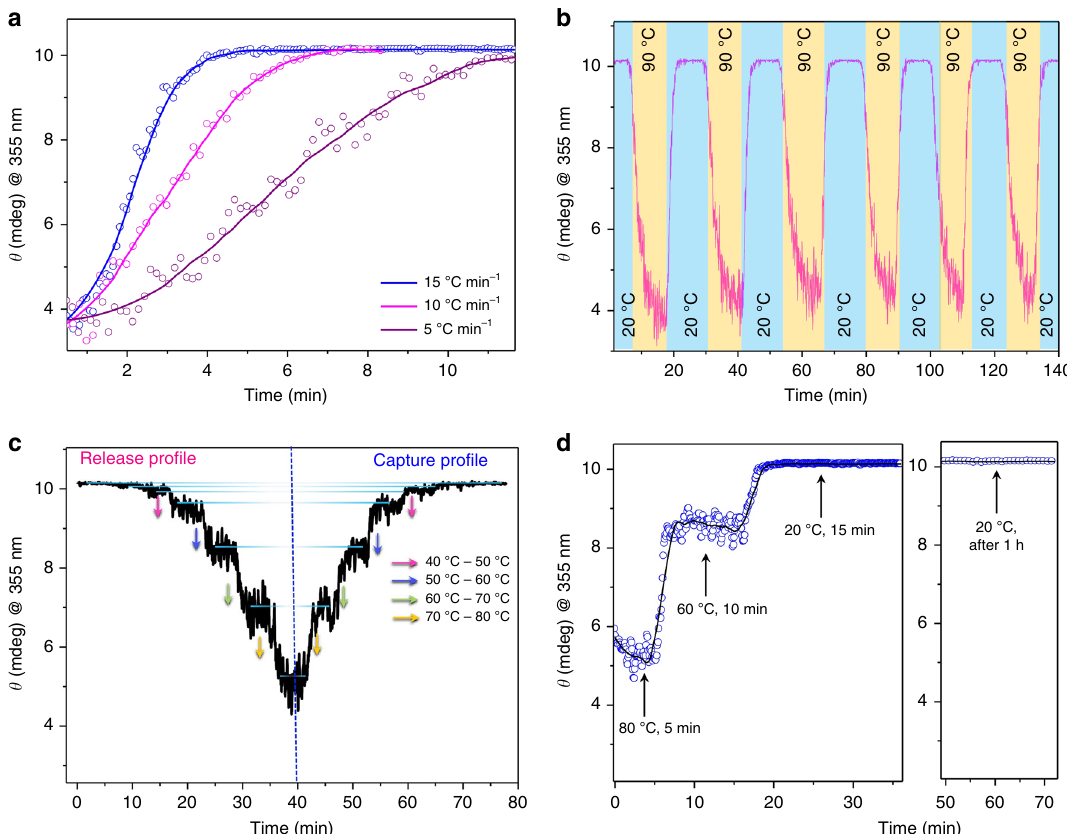
Fig. 6 Stepwise and reversibly controlled release and capture of α -CD by Mg-CP in solution state. a Temperature-dependent binding of α -CD by Mg-CP with cooling rate of the solution from 15 to 5 °C min − 1 . Non-linear fi t to the observed data points are also represented. b Thermally reversible binding (blue) and release (yellow) of α -CD by Mg-CP . c Stepwise release and capture of α -CD by Mg-CP . The arrows represent the speci fi c changes in the temperature. d A two-step capture pro fi le of α -CD from Mg-CP . The ICD signal remains stable at a particular temperature for the desired amount of time. The plot on the right shows no release of α -CD from Mg-CP at 20°C even after 1 h. Concentration of Mg-CP is 0.06 mg mL − 1 and that of α -CD is 1 × 10 − 3 M for